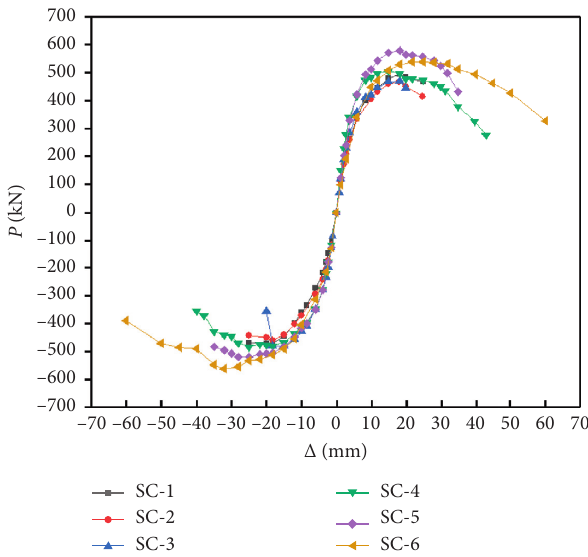
Figure 8: Skeleton curves of specimens. Skeleton curves represent the outer winding line of the peak loading point of each stage.